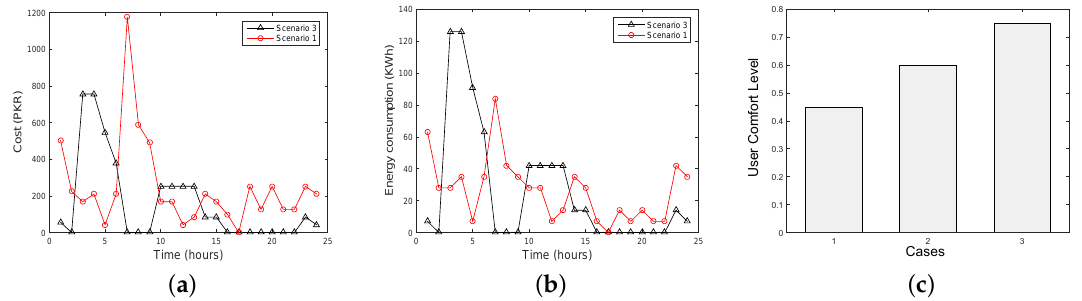
Figure 7. EMS: by using the optimization technique (Scenario 3). ( a ) Cost profile (Scenario 3); ( b ) load profile (Scenario 3); ( c ) UCL when: Case 1: α , ζ = 0.3,0.7; Case 2: α , ζ = 0.5,0.5; Case 3: α , ζ = 0.7,0.3.